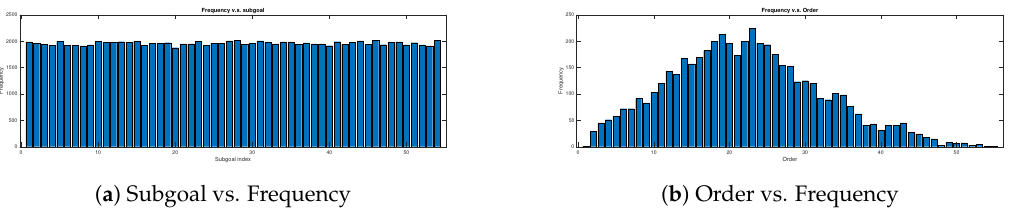
Figure 10. The distribution of 5000 test data. The subgoals are chosen uniformly, and the order of subgoals is normal.